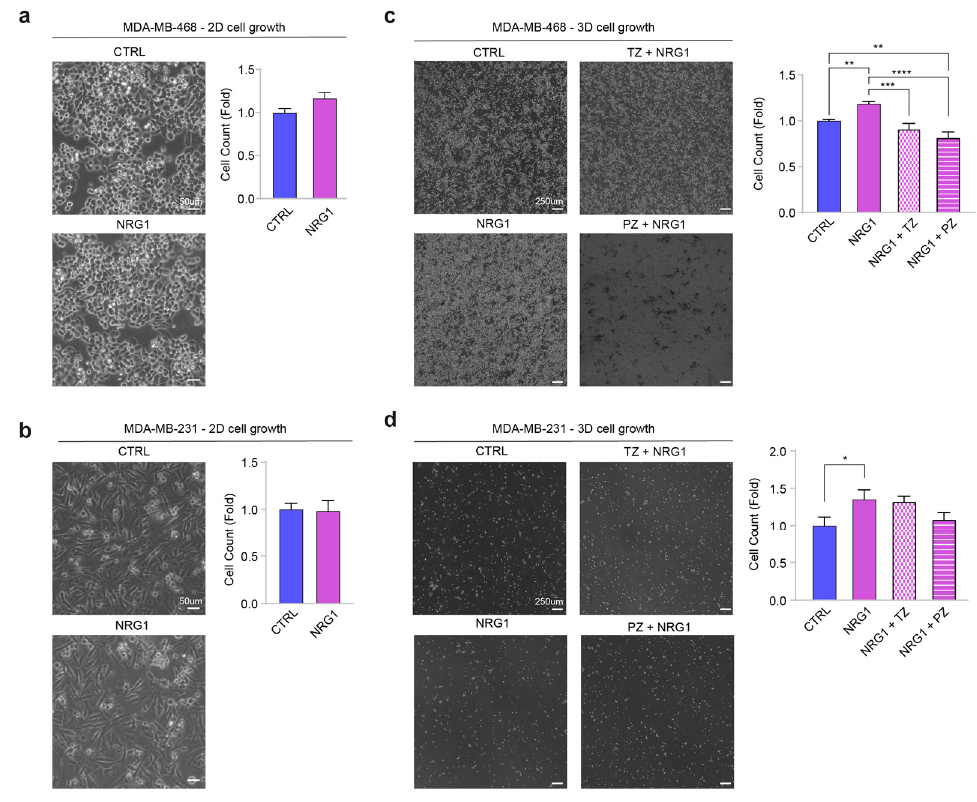
Figure 6. Administration of NRG1 β promotes the anchorage-independent growth of basal-like/triple-negative breast cancer cells. ( a , b ) Anchorage-dependent cell proliferation of MDA-MB-468 and MDA-MB-231 cells upon stimulation with NRG1 β . MDA-MB-468 and MDA-MB-231 cells were seeded in adherent conditions and stimulated with/without NRG1 β (10 ng/mL) for 72 h. Cell count for MDA-MB-468 and MDA-MB-231 is provided in ( a ) and ( b ), respectively. ( c , d ) Anchorage-independent cell growth of MDA-MB-468 and MDA-MB-231 cells upon stimulation with NRG1 β and simultaneous inhibition of ERBB2 by trastuzumab (TZ) or pertuzumab (PZ). MDA-MB-468 and MDA-MB-231 cells were seeded in ultra-low attachment plates and stimulated with/without NRG1 β (10 ng/mL), alone or in combination with trastuzumab (10 µg/mL) or pertuzumab (10 µg/mL). Stimulations were repeated every 3 days for up to 14 days. Representative pictures and cell count for MDA-MB-468 and MDA-MB-231 are provided in ( c ) and ( d ), respectively. In all panels, numerical data are normalized to control cells and presented as mean (error bars show s.e.m.); statistical significance was determined using Student’s t -test in ( a , b ), and one-way ANOVA followed by Tukey’s test in ( c , d ); * p < 0.05, ** p < 0.01, *** p < 0.001, and **** p < 0.0001.